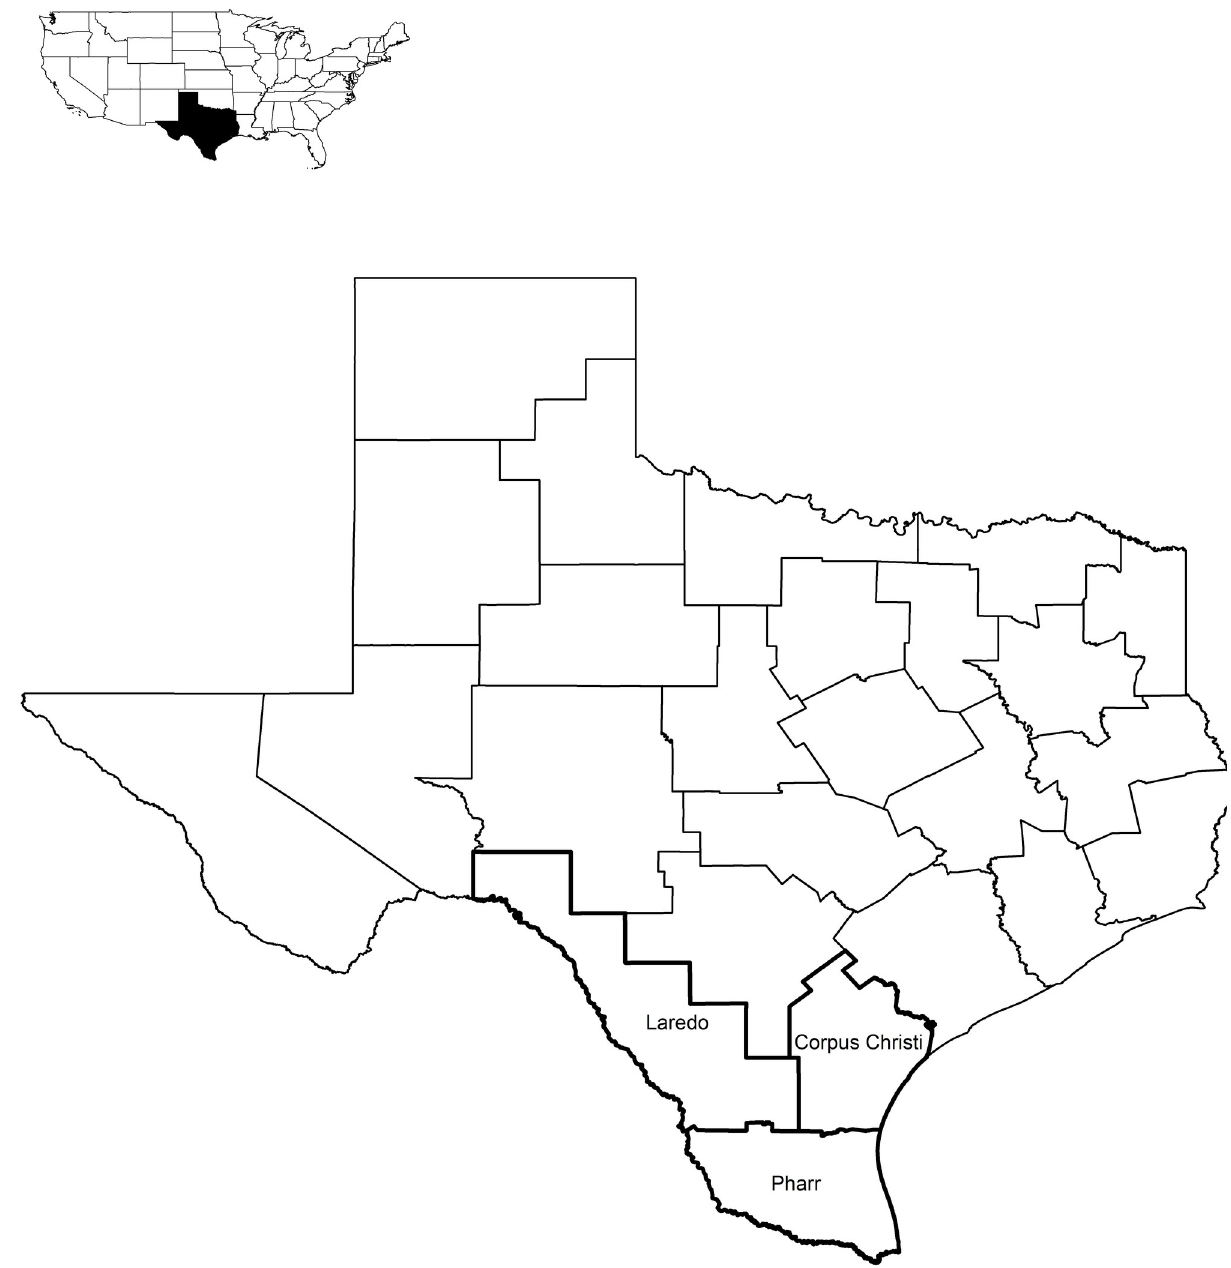
Fig 1. Districts defined by the Texas Department of Transportation, highlighting Laredo, Corpus Christi, and Pharr districts. Boundary data from TxDOT Open Data Portal, original copyright 2018.